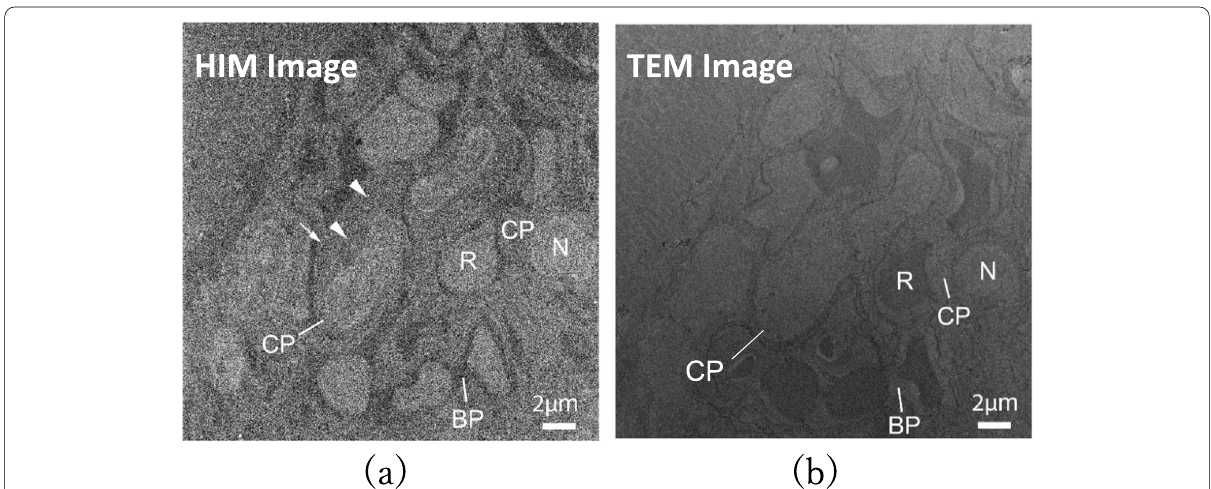
Fig. 10 a A HIM image without any sample treatment and b a TEM image with electronic staining of mouse kidney tissue sections in which blood plasma (BP), cytoplasm (CP), red blood cells (R), and nuclei (N) can be identified. The HIM image shows the same or higher contrast than the TEM image. Figure modified from